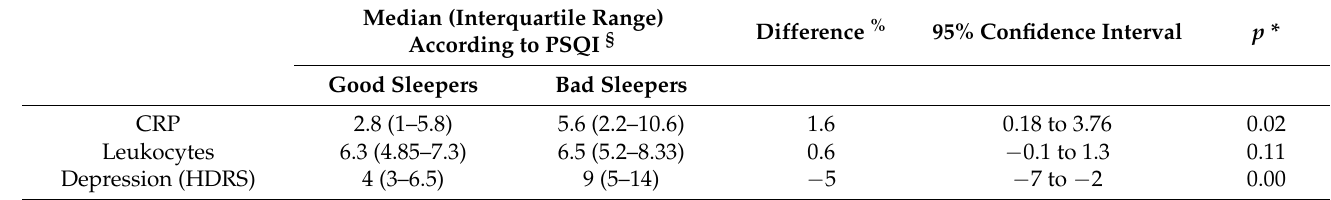
Table 7. Differences in biochemical indicators according to sleep quality (PSQI).